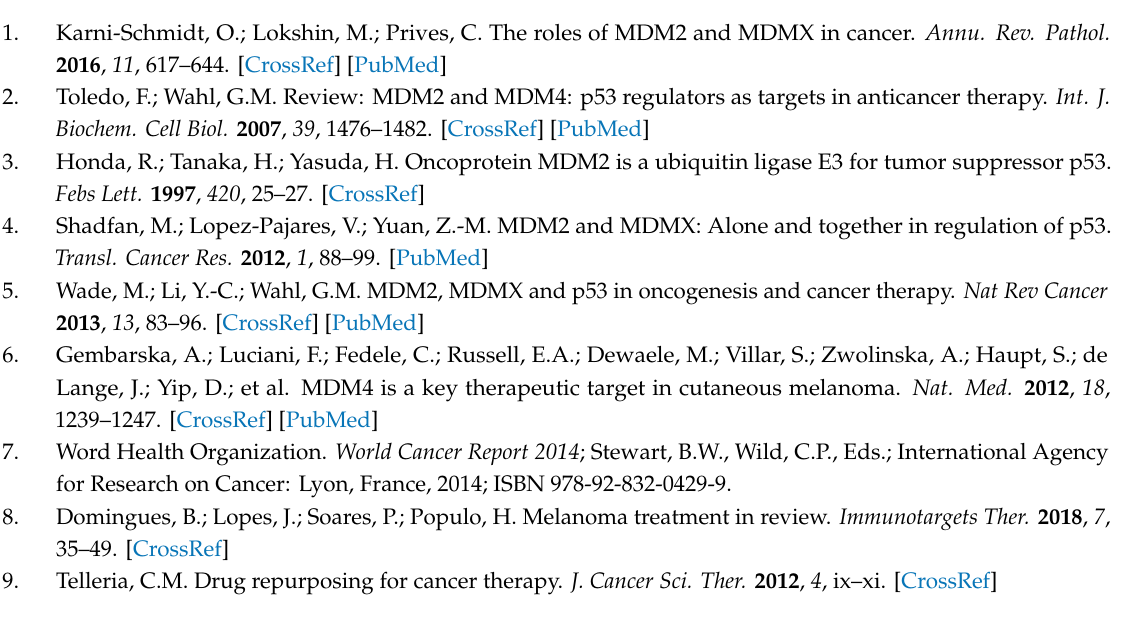
Table S2: Data obtained by pilot screen of A375-p53-Luc